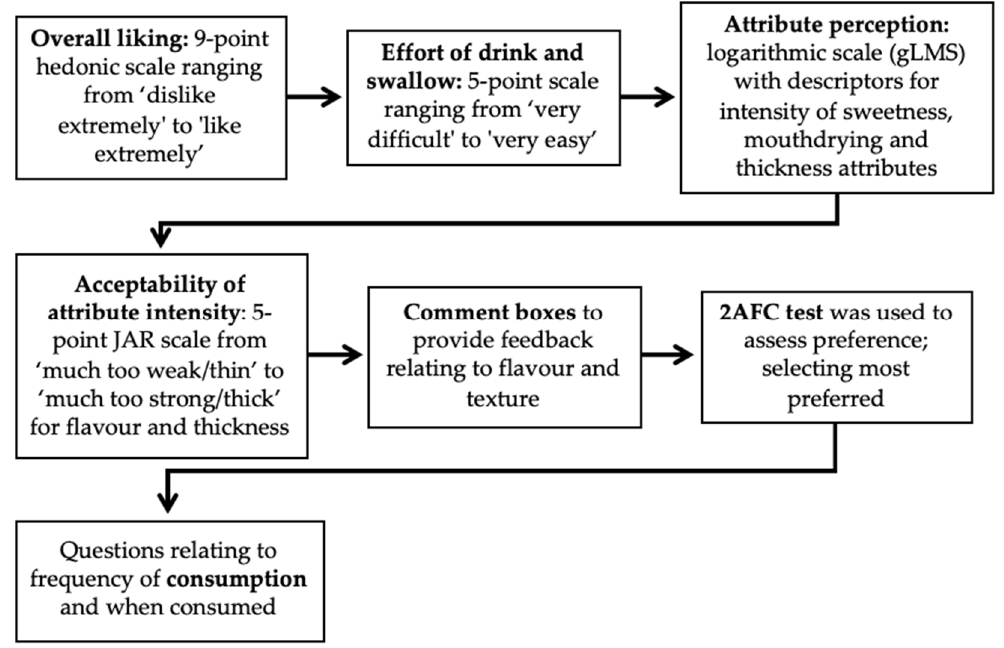
Figure 4. Overview of whey protein beverage (WPB) individual perception and liking (gLMS: generalised Labelled Magnitude Scale; JAR: Just-About-Right; 2AFC: two alternative forced choice).